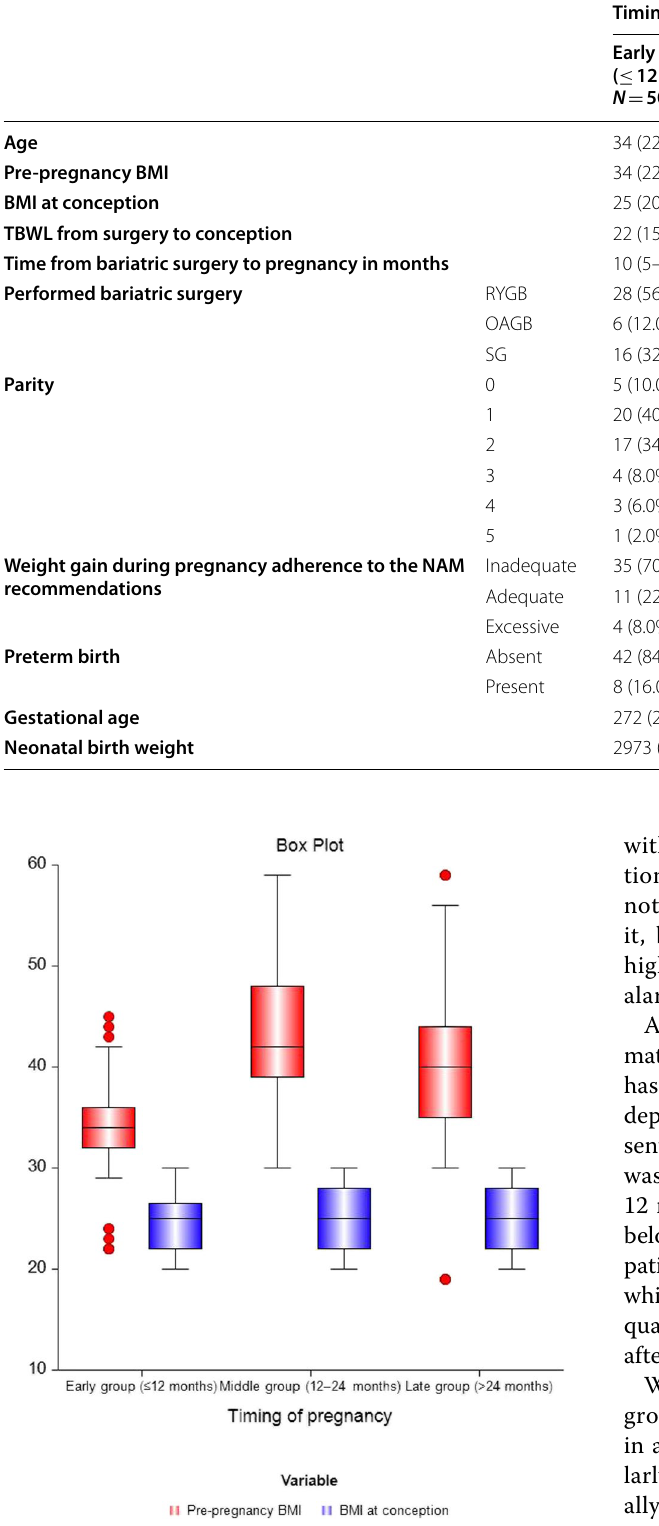
Table 2 Pre‑pregnancy, pregnancy, and neonatal findings according to time from surgery to